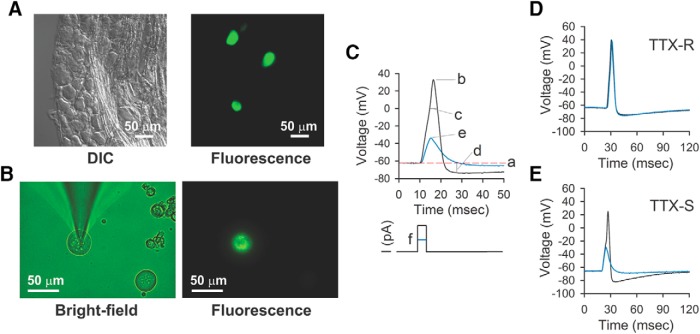
Analysis of electrical properties of bladder sensory neurons. DRGs were harvested from rats injected with DiI into the bladder wall. A, DIC and epifluorescence micrographies captured from a cryosection of a paraformaldehyde fixed DRG (L1). B, Bright field and epifluorescence micrographies of acutely isolated LS (L6-S2) DRG neurons captured during a patch-clamp experiment. C, Analysis of passive and active action potential properties. Representative voltage trace registered in the current-clamp mode with the perforated patch-clamp technique from a Dil-labeled bladder sensory neuron. Action potentials were evoked by 4-ms depolarizing current pulses through the recording electrode. The current injection protocol is shown beneath voltage trace. Letters refer to properties of the action potential examined. a, resting membrane potential; b, action potential overshoot (above 0 mV); c, action potential duration at 0 mV; d, magnitude of after hyperpolarization (AHP) below resting membrane potential (in mV); e, action potential threshold, which is defined as the greatest membrane potential (mV) achieved in response to a current pulse that does not trigger an action potential; f, rheobase, which is defined as the smallest amount of depolarizing current (pA) required to trigger an action potential. D, E, Classification of DiI-labeled bladder neurons on the basis of the sensitivity of the action potential to TTX. Representative tracing of DiI-labeled bladder neurons with TTX-R (D) and TTX-S (E) action potentials.